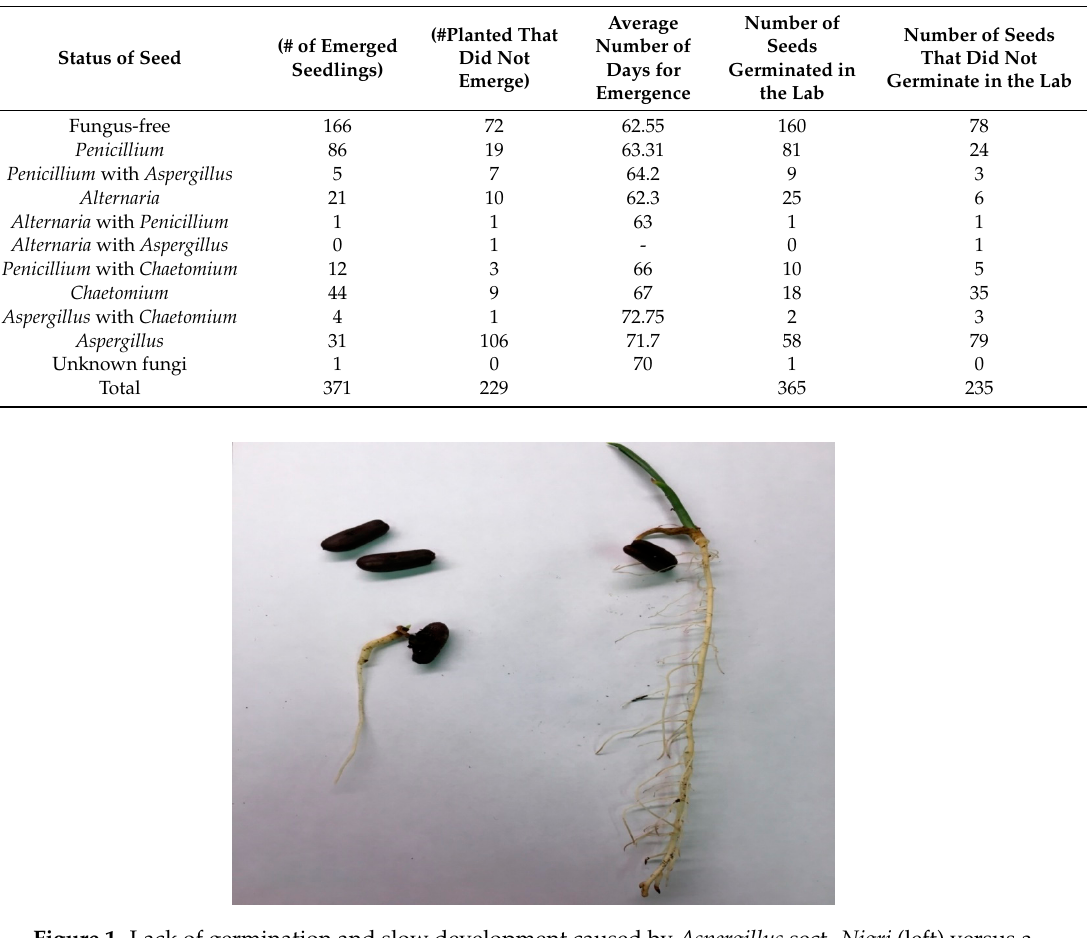
Table 2. E ff ects of fungal status on germination of the 600 seeds in the lab followed by seedling emergence in potting mix in the greenhouse. Aspergillus here refers to Aspergillus sect. Nigri .